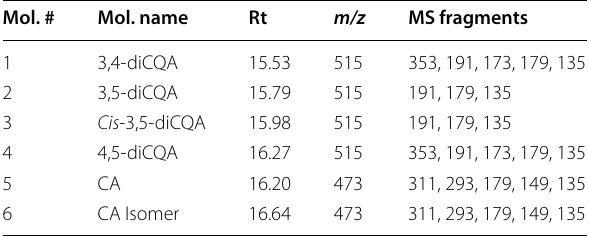
Mol molecule; Rt retention time; m/z mass to charge ratio